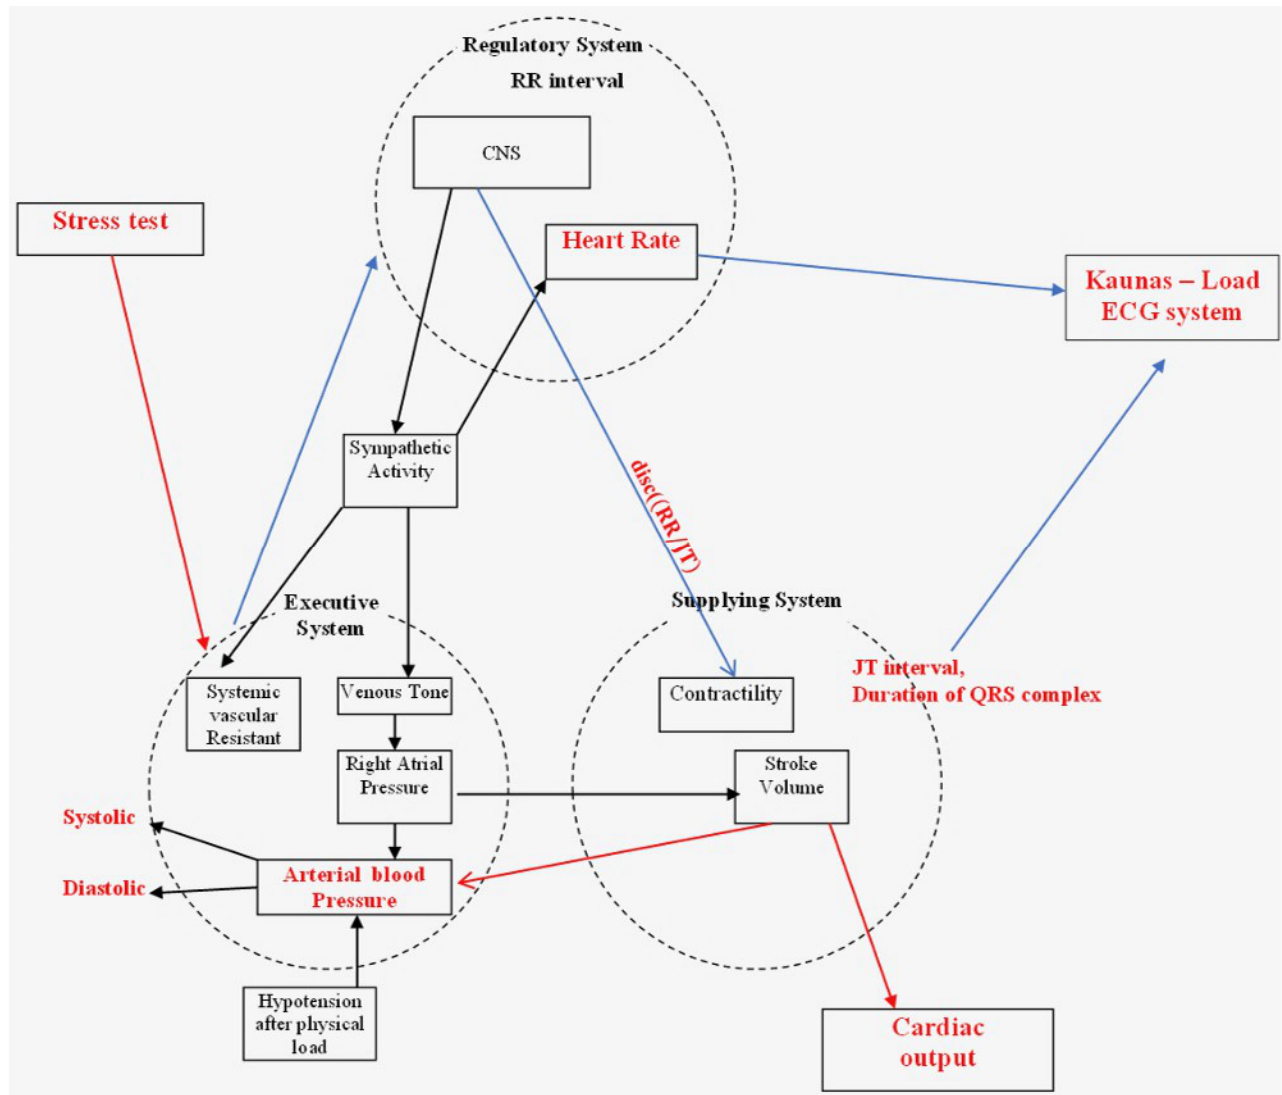
Figure 1. A schematic diagram illustrating the interconnectivity of the Executive System, the Supply System, and the Regulatory